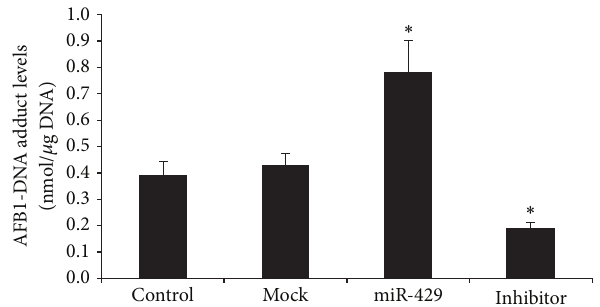
Figure 5: AFB1-DNA adducts formation in AFB1-treated SMMC- 7721 cells with overexpression of miR-429 (see Section 2). Levels of AFB1-DNA adducts were tested using comparative ELISA. Data were analyzed from three independent tests using one-way ANOVA with Bonferroni corrections. ∗ 𝑃 < 0.05